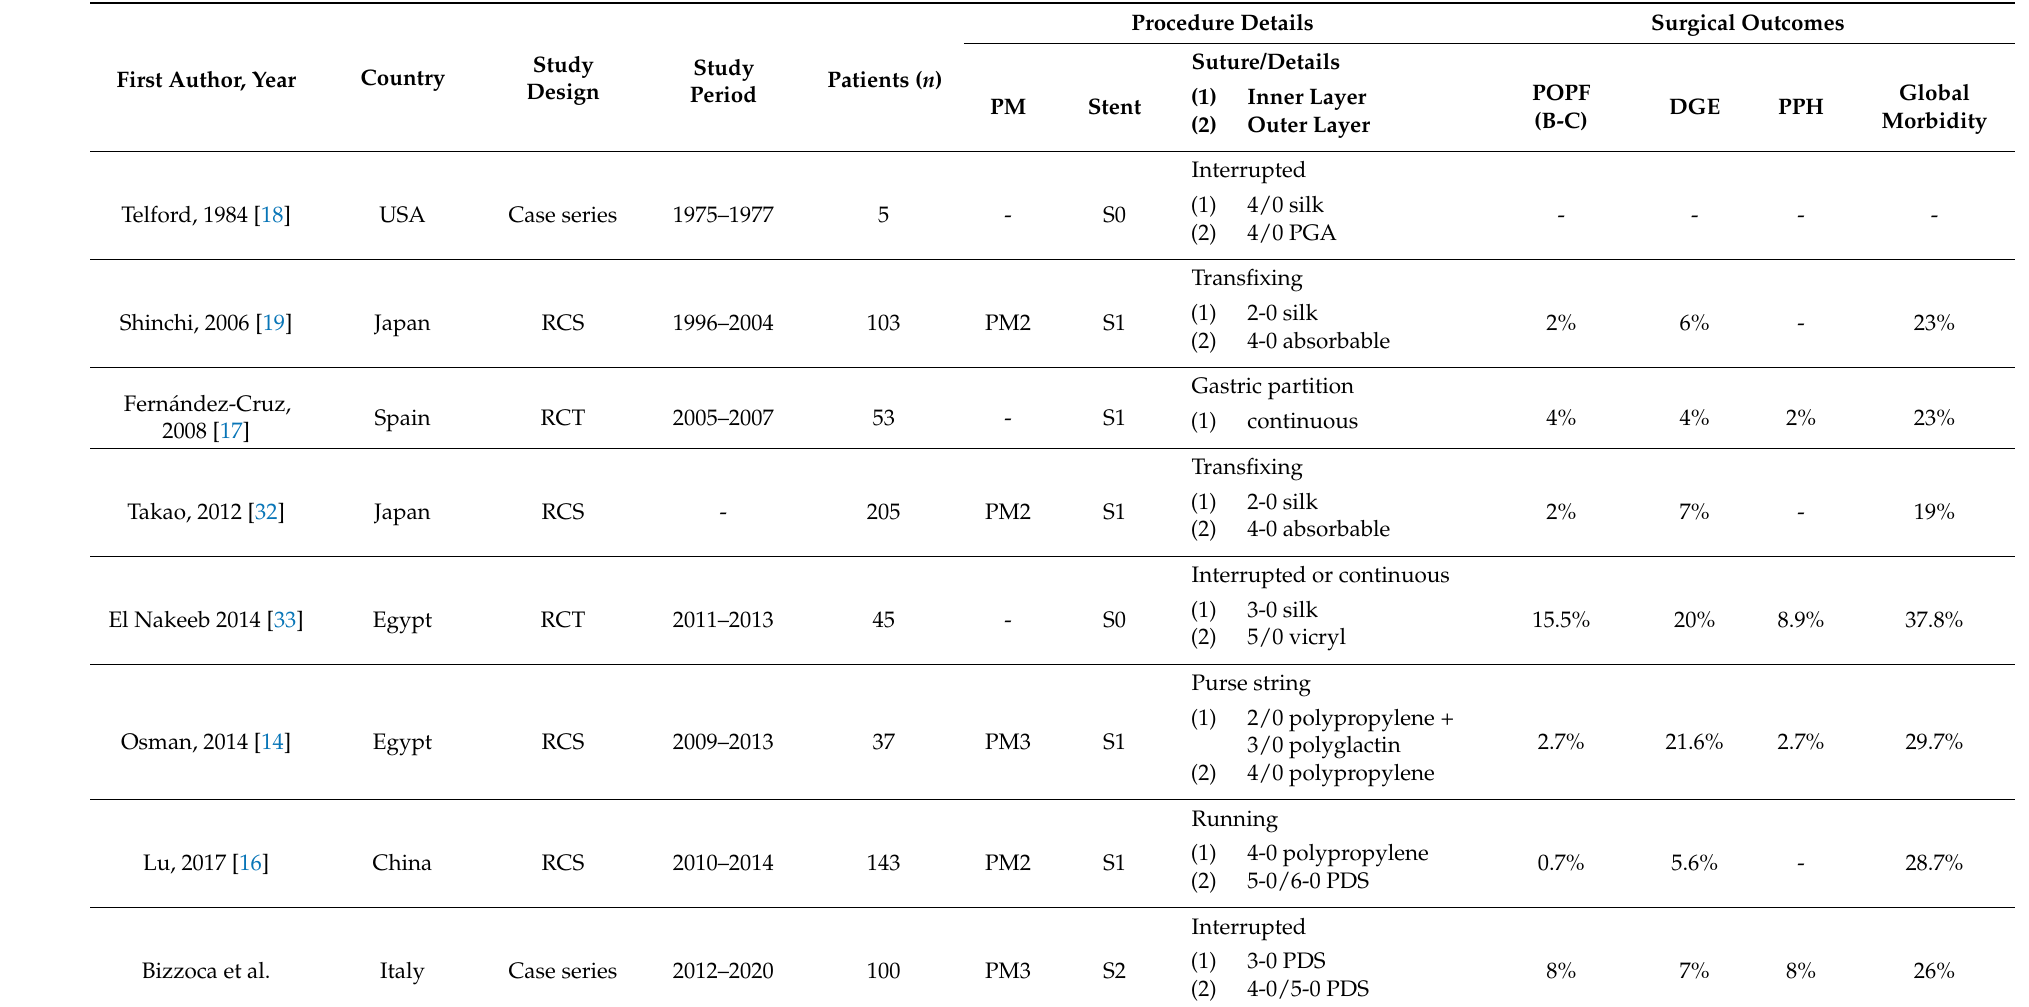
Table 5. Characteristics of the studies included in the systematic review